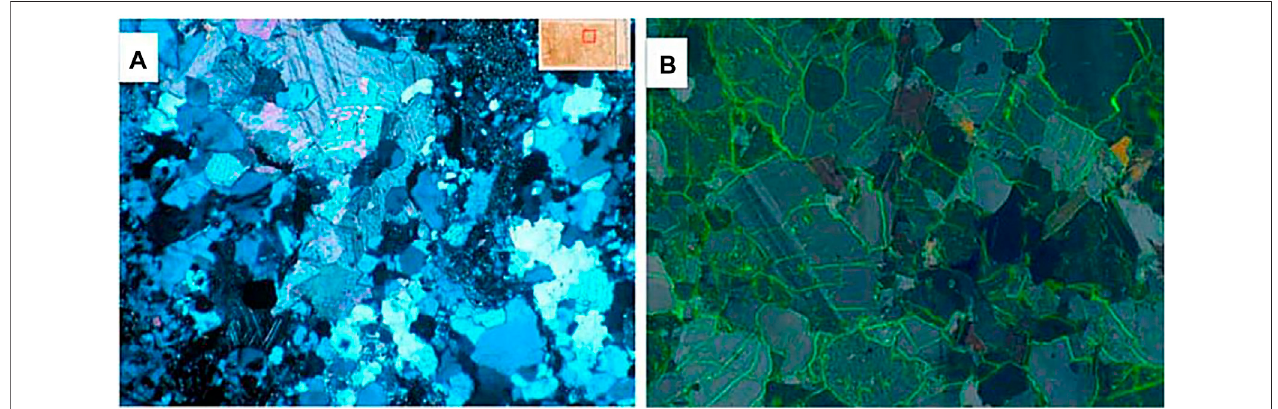
Frontiers in Earth Science |